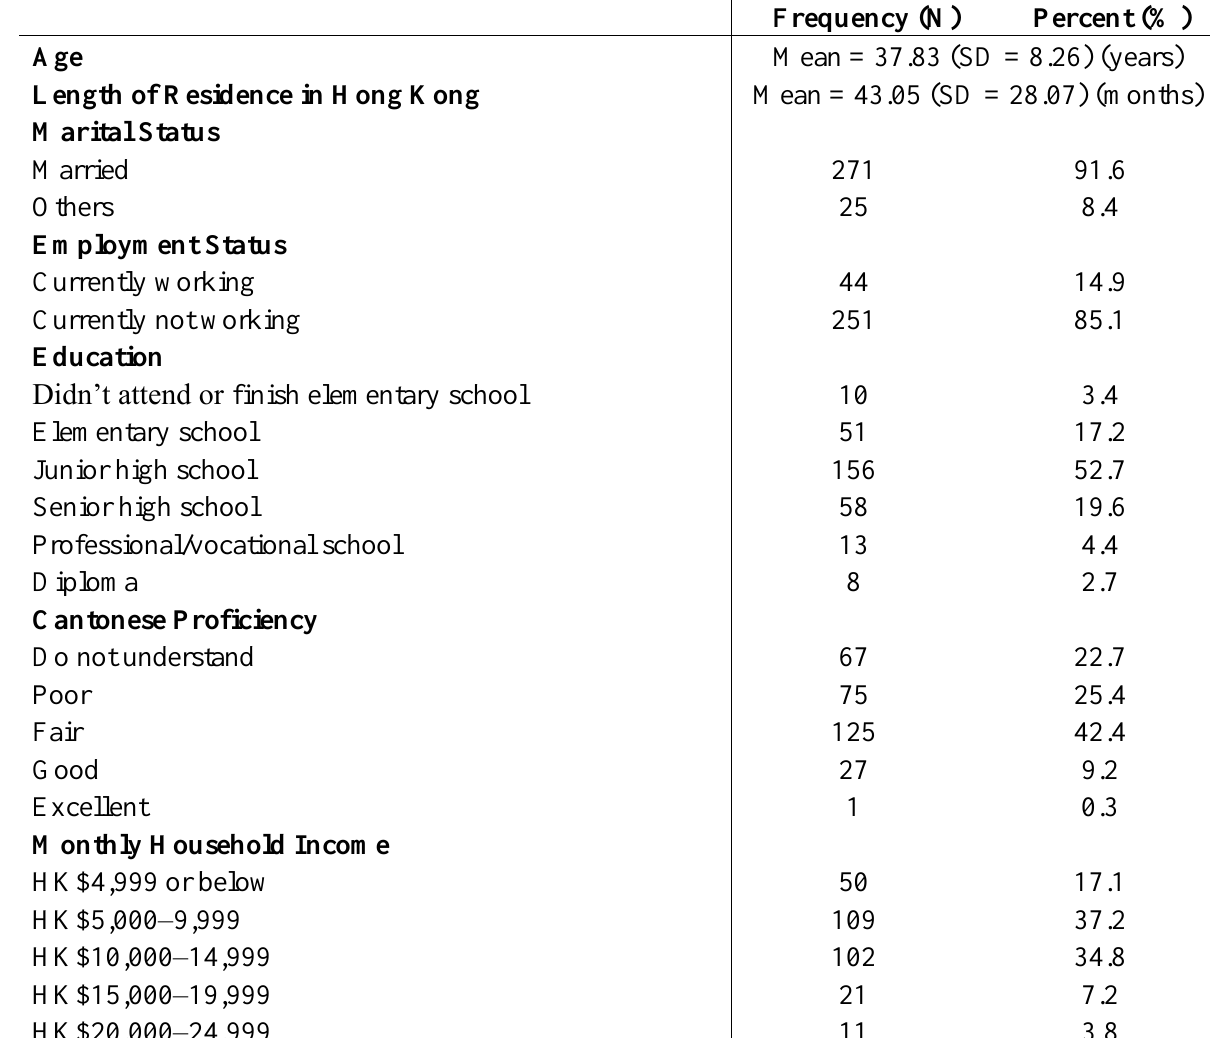
Table 1. Descriptive statistics of sample